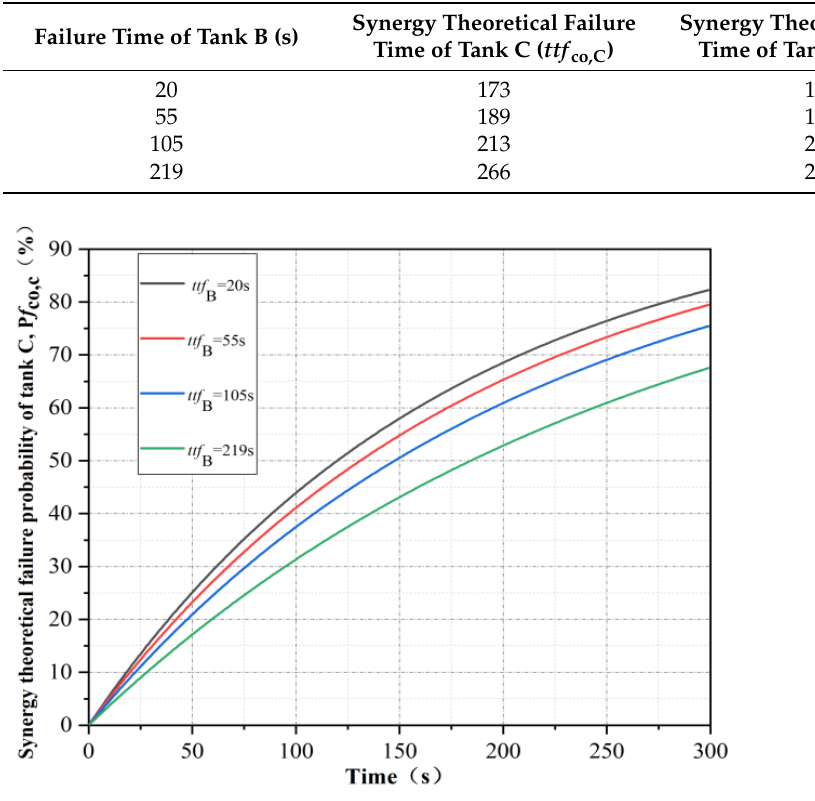
Figure 7. Synergy theoretical failure time of tanks C and D.